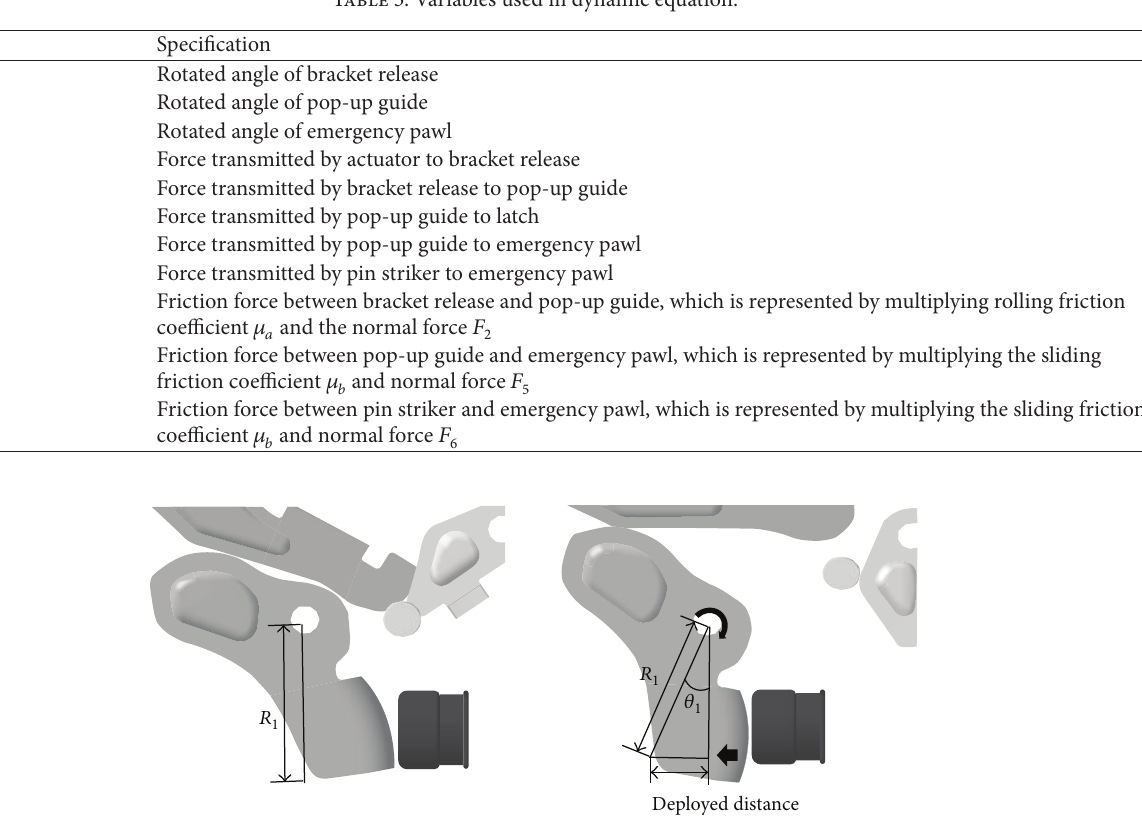
Figure 7: Schematic diagram of deployed distance of